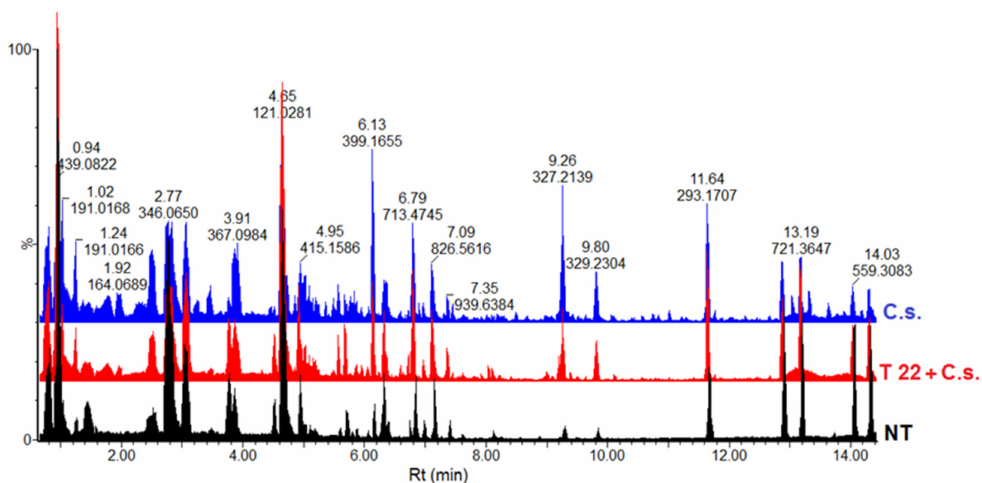
Figure 1. Representative UHPLC-MS chromatograms of ESI(-) data (5 d.p.i.). Base peak intensity (BPI) mass chromatograms displaying comparative chromatographic di ff erences in di ff erent conditions: (i) samples from non-treated plants (NT), (ii) samples from P. alvei (T22)-primed and C. sublineolum ( C.s .)-challenged plants and (iii) samples from C.s. -infected plants. Visual inspection of the chromatograms evidently shows di ff erential peak populations, for instance in the 4–12 min retention time (Rt)